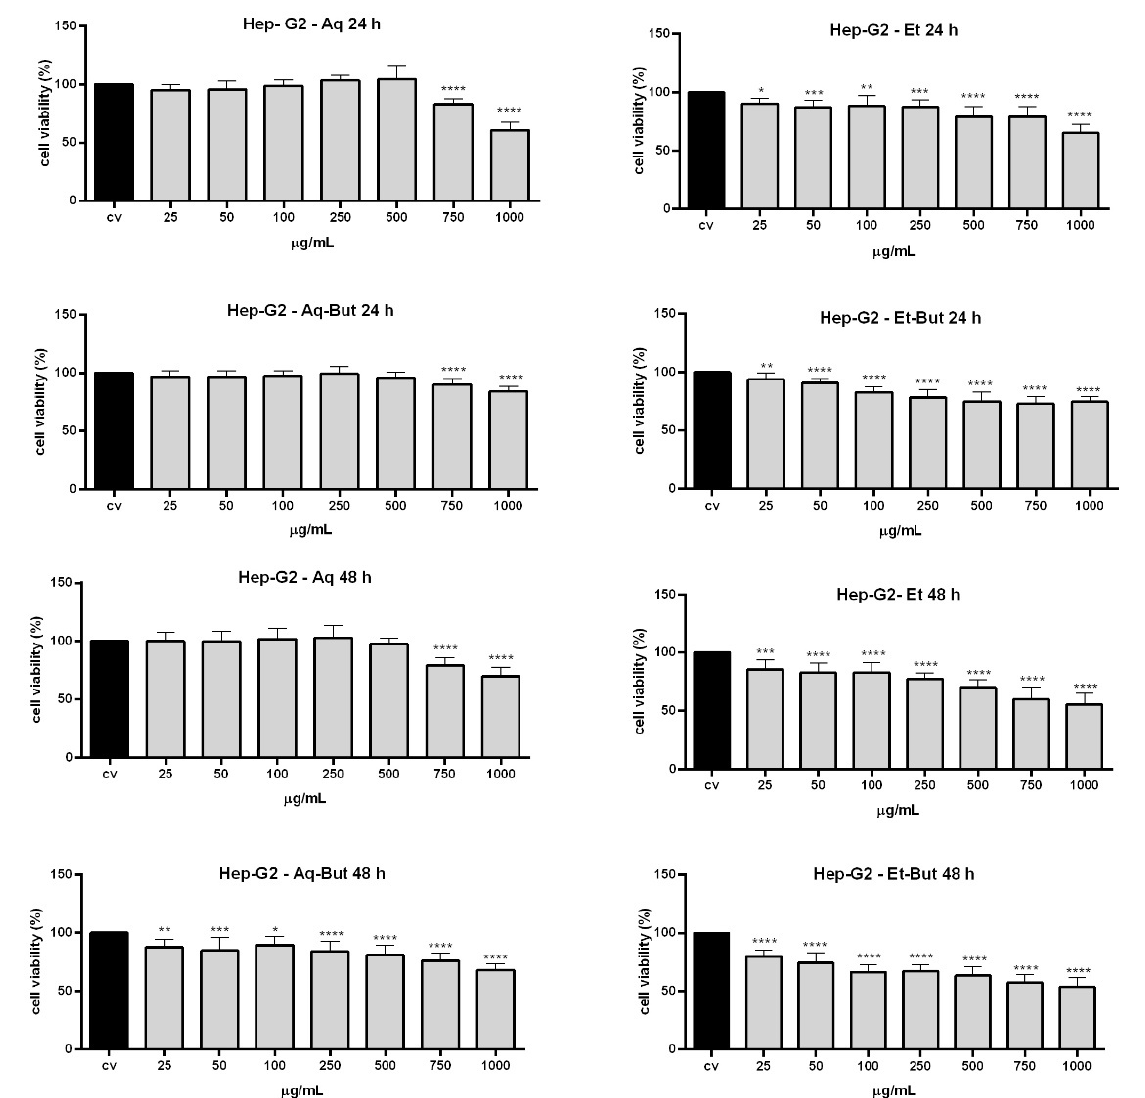
Figure 4. Cytotoxicity analysis of M. albicans extracts on Hep-G2 cells evaluated by PrestoBlue ® . Cells were incubated with aqueous and ethanolic extracts, as well as their butanol fractions (25, 50, 100, 250, 500, 750, and 1000 µ g/mL), for 24 h and 48 h. Statistical analyses were performed by one-way analysis of variance (ANOVA), followed by Bonferroni’s test, for selected pairs. Results represent the mean ± SD of two independent experiments ( n = 2, in triplicate); * p < 0.05, ** p < 0.01, *** p < 0.001, **** p < 0.0001 versus vehicle control (V).